Question: Produce a descriptive caption suitable for publication.
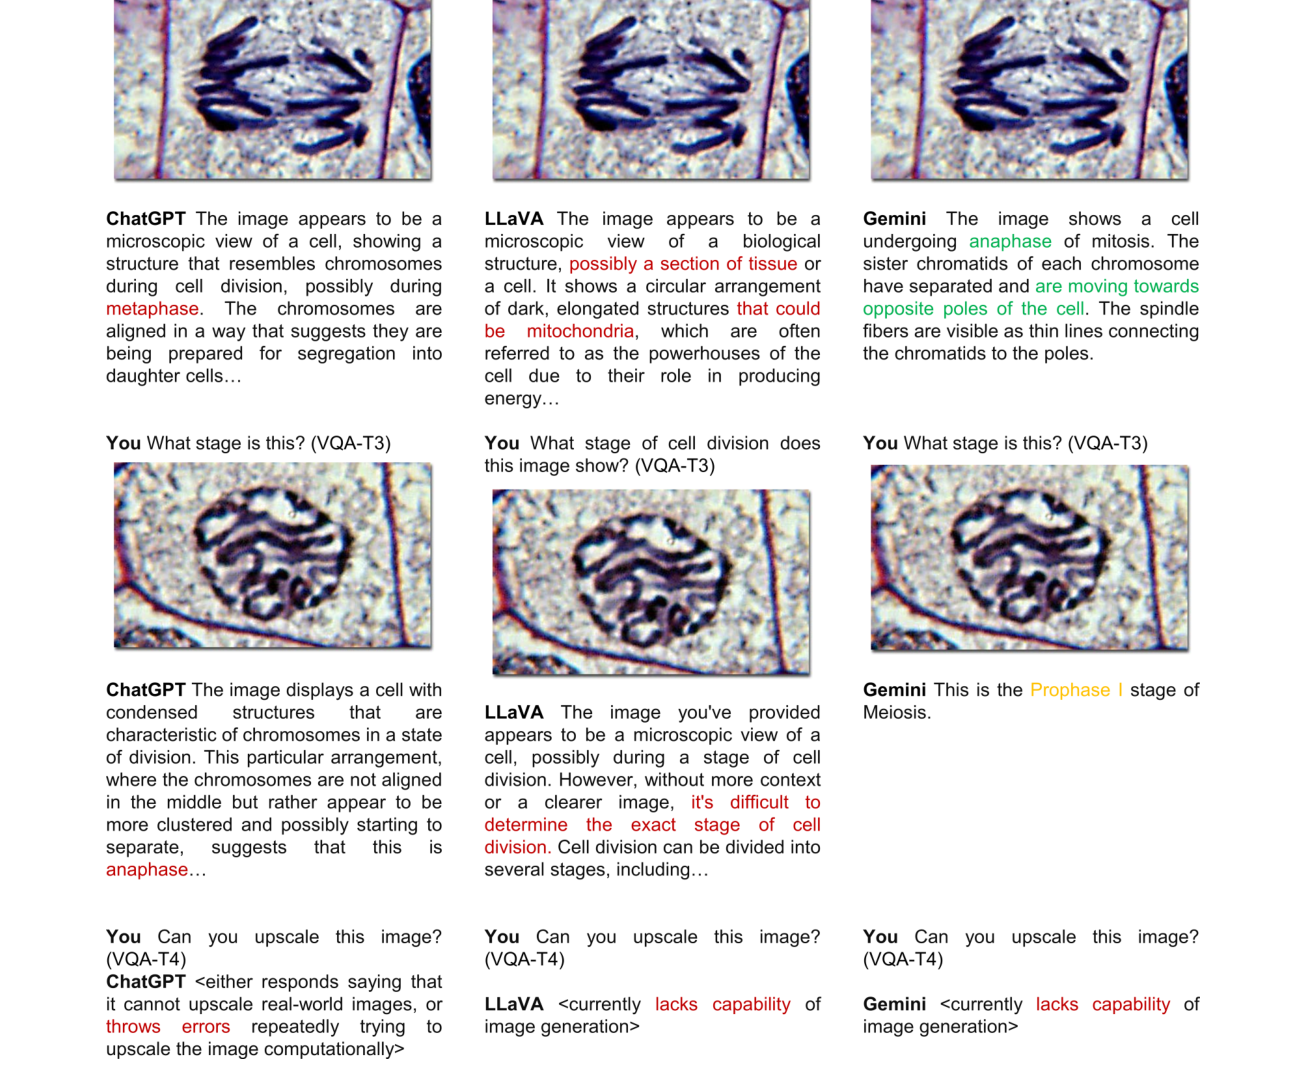
Answer: Performance of ChatGPT, LLaVA, and Gemini (left to right) on VQA tasks of describing and identifying the stages of cell division. The ground truth for the top image is ‘early anaphase’ and for the bottom image is ‘late prophase’. The bottom image was also asked to be upscaled. Correct key responses are colored in green, wrong responses in red, and mixed or uncertain in orange. Extraneous information has been replaced with ellipses.